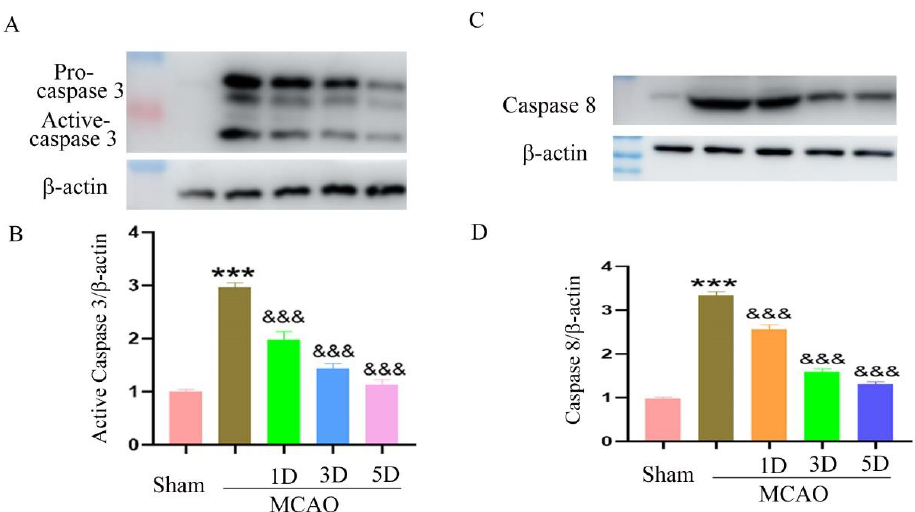
Figure 2. The expression of apoptosis-regulating proteins were detected by Western blot method following middle cerebral artery occlusion and treadmill exercise. ( A ) The expression level of activated forms of caspase 3 were detected with Western blot in mouse brain with middle cerebral artery occlusion and treadmill exercise 1D, 3D, and 5D; ( B ) Statistical analysis of the expression level of activated forms of caspase 3 in ( A ); ( C ) The expression level of activated forms of caspase 8 were detected with Western blot in mouse brain with middle cerebral artery occlusion and treadmill exercise 1D, 3D, and 5D; ( D ) Statistical analysis of the expression level of activated forms of caspase 8 in ( C ). (*** p < 0.001 vs. Sham; &&& p < 0.001 vs. MCAO, n = 3).